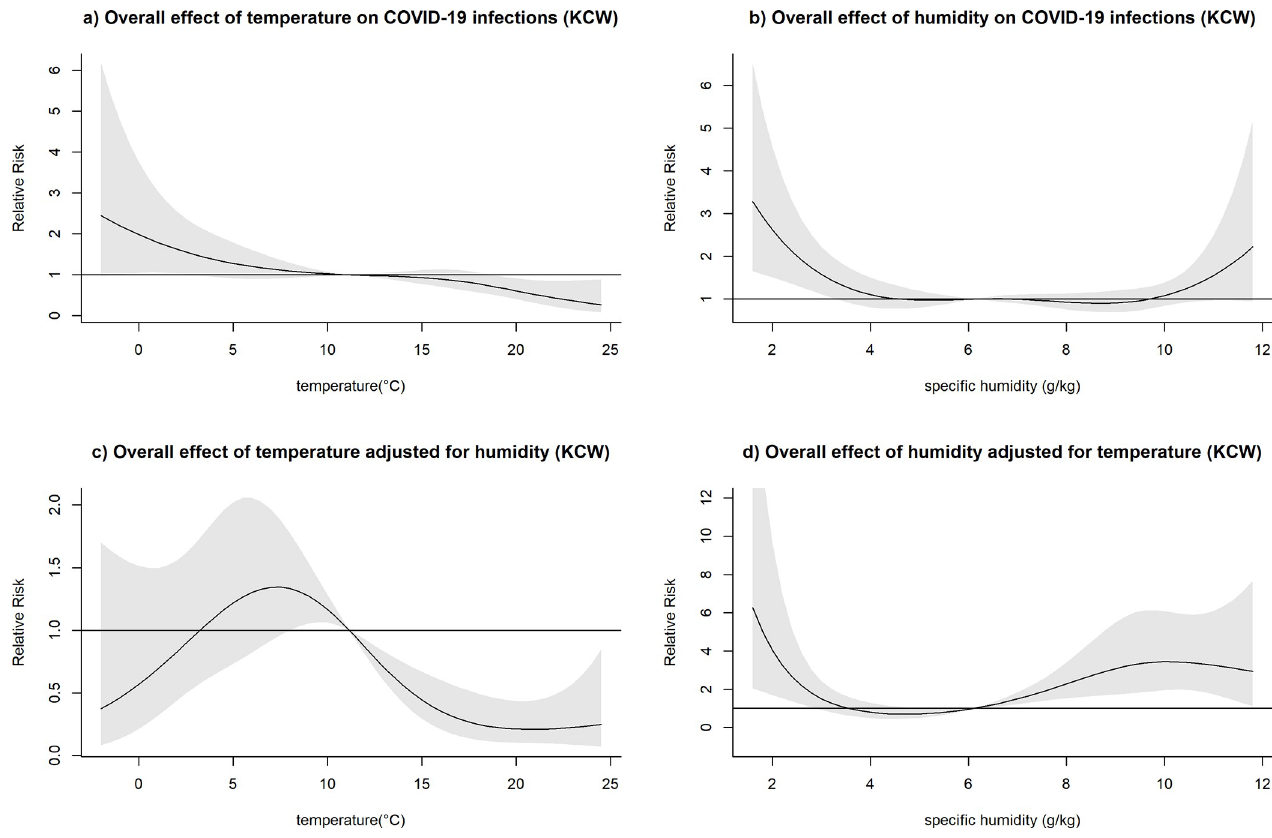
Fig 7. Overall effect of temperature and humidity on COVID-19 infections in Seattle and King County, Washington (KCW). The relative risk of COVID- 19 infection was plotted across the range of temperature/humidity to show the a) Unadjusted effect of temperature; b) Unadjusted effect of humidity; c) Effect of temperature adjusted for humidity; d) Effect of humidity adjusted for